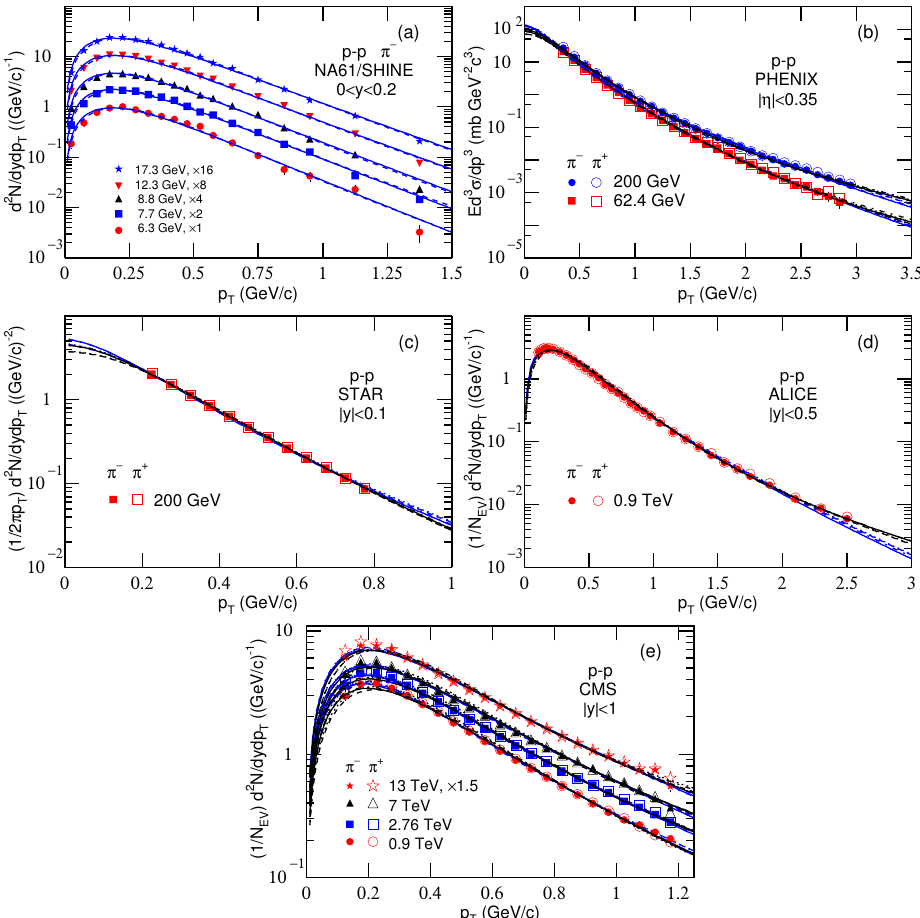
Figure 1. Transverse momentum spectra of π − and π + produced at mid-(pseudo)rapidity in pp collisions at high energies, where the mid-(pseudo)rapidity intervals and energies are marked in the panels. The symbols presented in panels ( a – e ) represent the data of NA61/SHINE [24], PHENIX [25], STAR [6], ALICE [26], and CMS [27,28] Collaborations, respectively, where in panel ( a ) only the spectra of π − are available, and panel ( c ) is for NSD events and other panels are for INEL events. Although the pp collisions are divided on the multiplicity classes in experiments on the LHC, we have used the minimum-bias INEL events [26–28]. In some cases, different amounts marked in the panels are used to scale the data for clarity. The blue solid (dotted) curves are our results for π − ( π + ) spectra fitted by Equation (7) through Equations (1) and (3), and the blue dashed (dot-dashed) curves are our results for π − ( π + ) spectra fitted by Equation (7) through Equations (2) and (3), by the first set of parameter values. The results by the second set of parameters (if available) are presented by the black